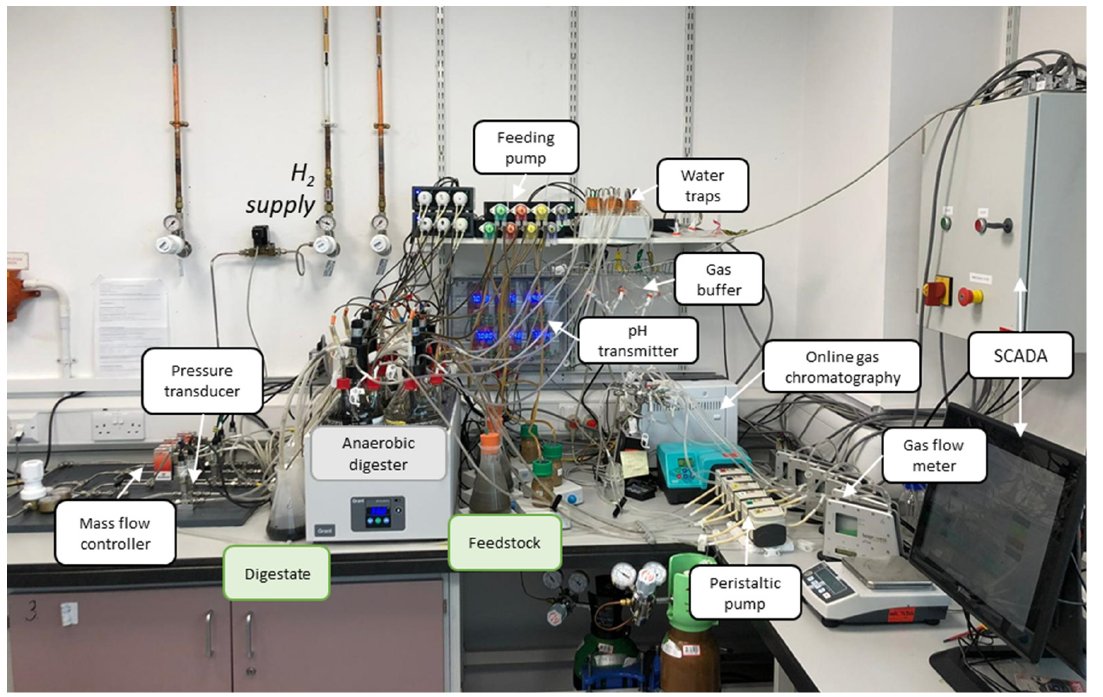
Figure 2. Photo of the in-situ biomethanation experimental rig with main components labelled. The main features of the experimental setup were as follows.